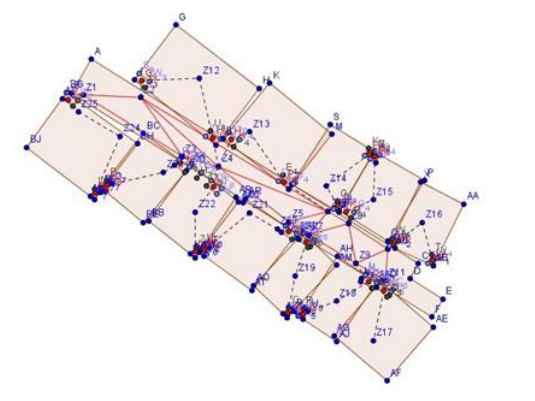
Figure 2: Position of control points by Trimble LaserAce